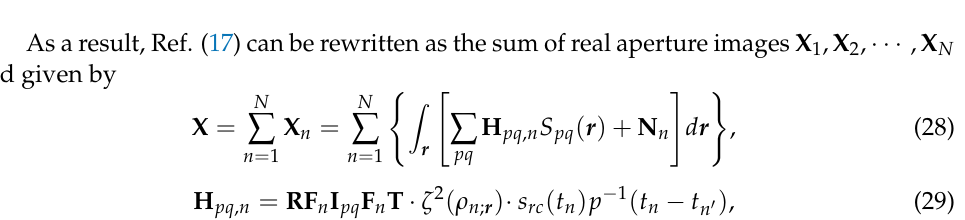
Figure 4. A schematic diagram for the aperture dependence and spatial variation of the scintilla- tion